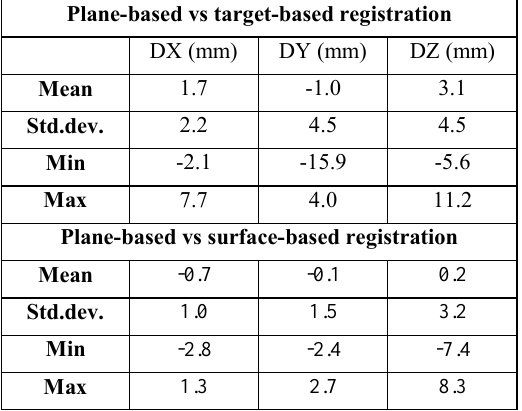
Table 1. Case Study 1: statistics on the differences of scan locations computed with three registration methods.